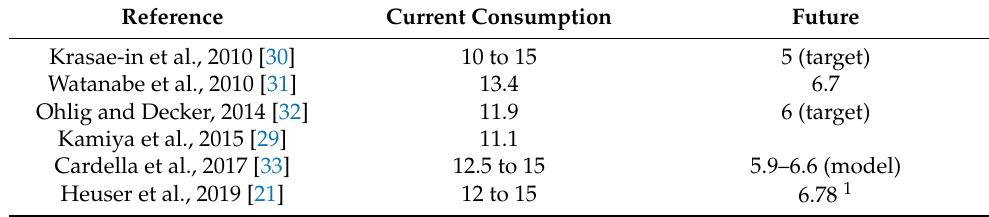
Table 3. Selected current and projected energy requirements for hydrogen liquefaction in